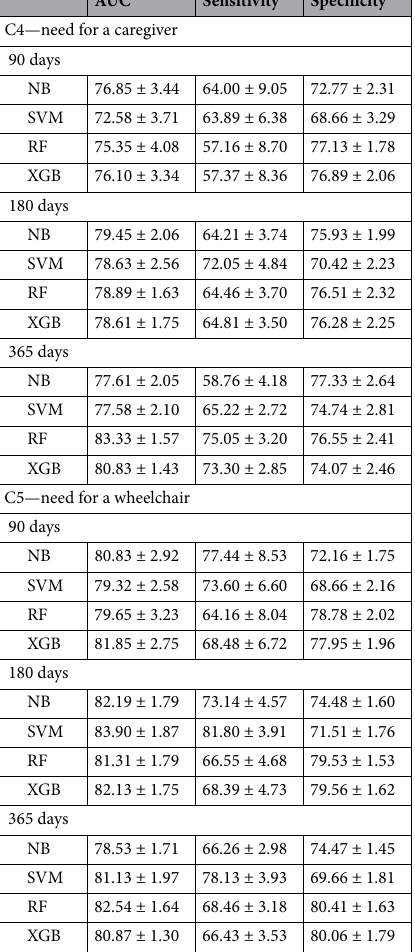
Table 7. Baseline results using data preprocessed following the approach proposed by Carreiro et al. 12 learned with 4 classifiers: Naive Bayes (NB), Support Vector Machine (SVM), Random Forests (RF) and XGB (eXtreme Gradient Boosting) to predict the Evolution for each of the target endpoints, C4 and C5, within the considered time windows (90, 180 and 365 days),